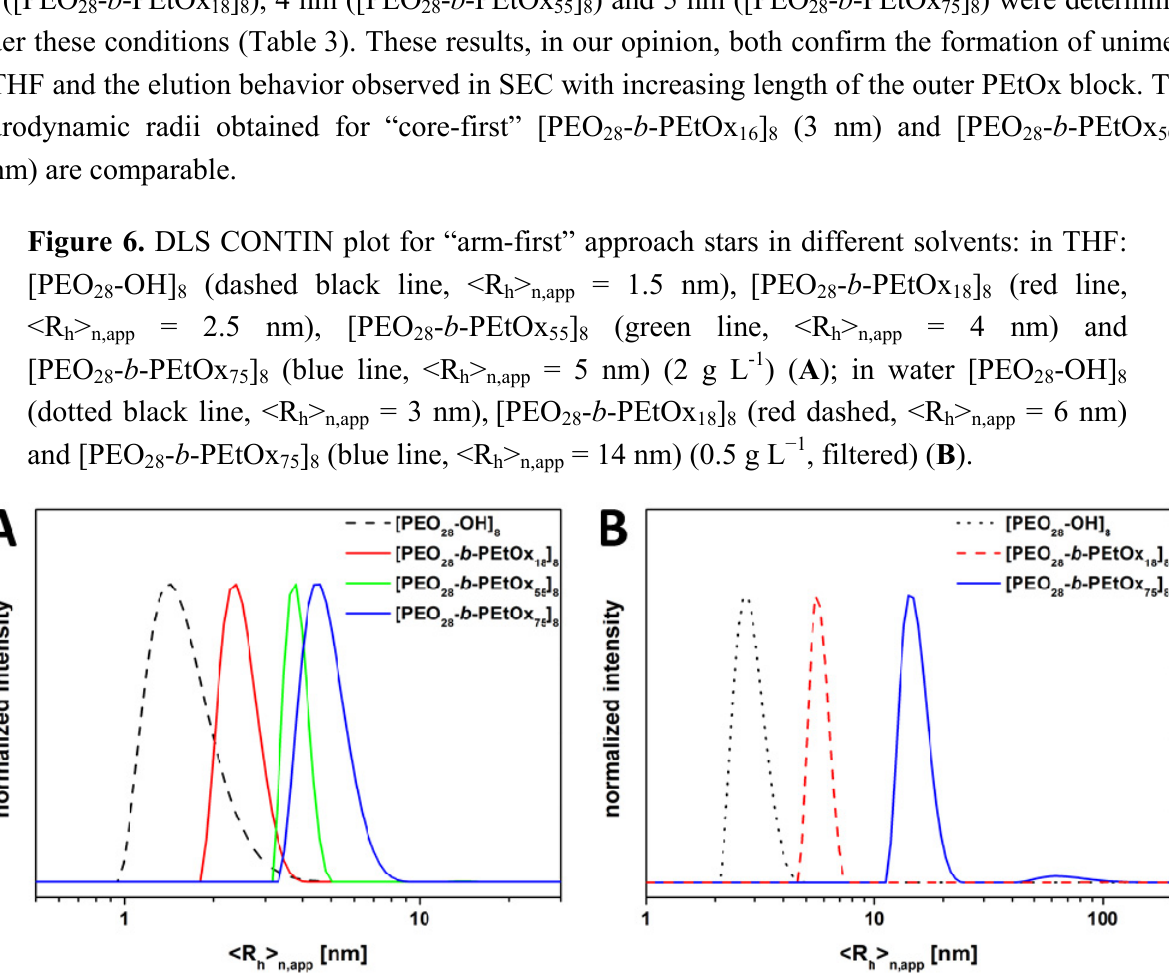
> ) for different star h n,app